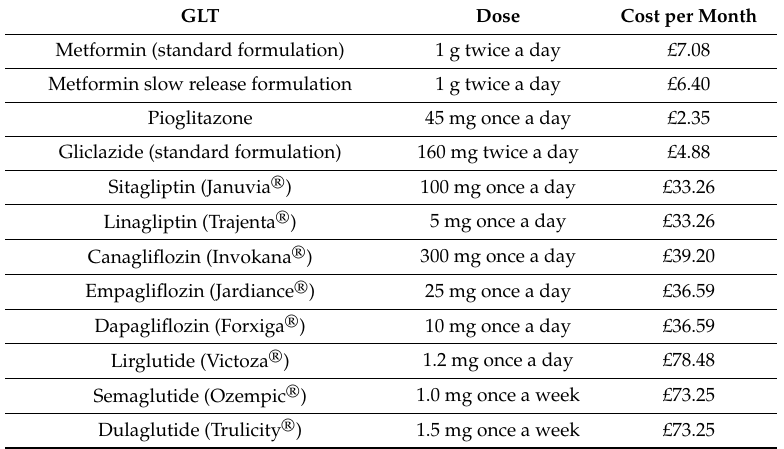
Table2. Average1-monthcostofcommonlyusedGLTsassumingfrequently /